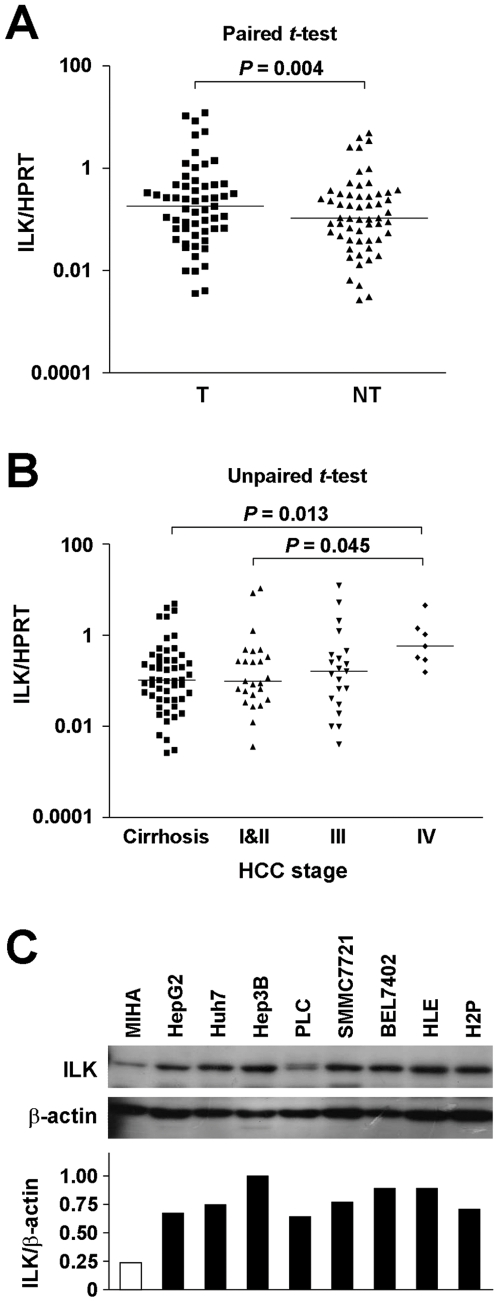
ILK expression was elevated in HCC clinical samples and cell lines.(A) ILK mRNA expression was examined by qPCR. ILK was overexpressed in 36.9% of the HCC samples. Cases with T/NT ratio >2 were classified as overexpression, while those with T/NT ratio <0.5 were regarded as underexpression. The remaining cases with 0.5< ratio <2 were regarded as no change in ILK expression. Higher ILK expression (P = 0.004) was observed in tumor samples when compared to their non-tumor counterparts. (B) A stepwise increase of ILK expression along HCC tumor stage was observed. (C) ILK expression in a panel of HCC cell lines was analyzed by western blot analysis. MIHA is an immortalized non-tumorigenic liver cell line. Relative ILK expression normalized with corresponding β-actin expression was shown below.